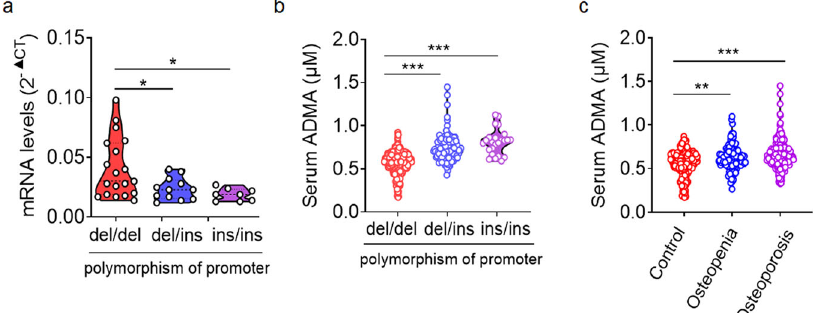
Fig. 1 Association of ADMA levels and the -394 4N del/ins polymorphism of Ddah1 with bone mineral density in a large Chinese population-based study. a qPCR of Ddah1 mRNA in hemocytes from patients with -394 del/del, -394 del/ins and -394 ins/ins Ddah1 genotypes. ** p < 0.01. del/del, n = 19. del/ins, n = 12. ins/ins, n = 8. Data are represented as mean values ± SD. The data were analyzed by an unpaired two-tailed Student ’ s t test in all panels. b Results from LC-MS assay for ADMA concentrations of the serum samples from -394 del/del, -394 del/ins and -394 ins/ins patients. ** p < 0.01. del/del, n = 420. del/ins, n = 126. ins/ins, n = 24. Data are represented as mean values ± SD. The data were analyzed by an unpaired two-tailed Student ’ s t test in all panels. c Results from LC-MS assay for ADMA concentrations of the serum samples from control, osteopenia and osteoporosis participants. ** p < 0.01. *** p < 0.005. control, n = 190. osteopenia, n = 117. osteoporosis, n = 263. Data are represented as mean values± SD. The data were analyzed by an unpaired two-tailed Student ’ s t test in all